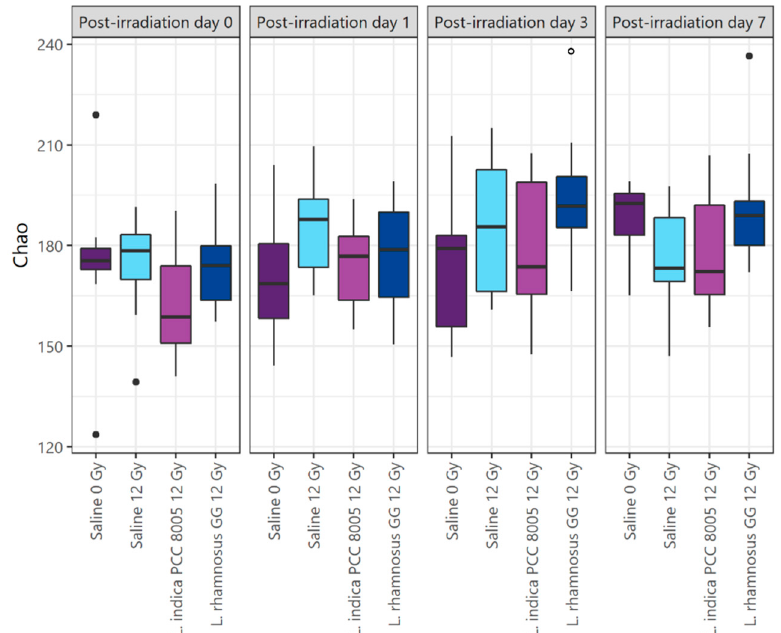
Figure 8. Changes in alpha diversity index Chao, considering solely richness, following (sham-)irradiation. Data are presented in boxplots and outliers are depicted by dots, n = 10 per group. Time-independent differences were assessed by Mann–Whitney’s U test (Bonferroni’s post hoc correction). Time-series, pairwise comparisons in respect to post-irradiation day 0 using ° p <0.05 were performed by Wilcoxon’s signed rank test (Bonferroni’s post-hoc correction).